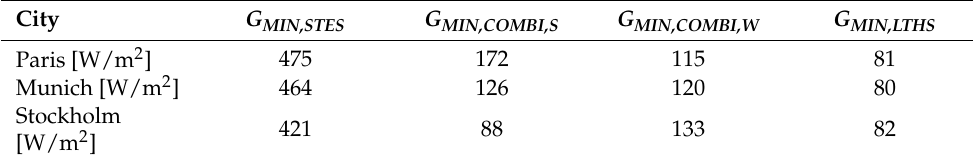
Table 8. Optimal control thresholds.